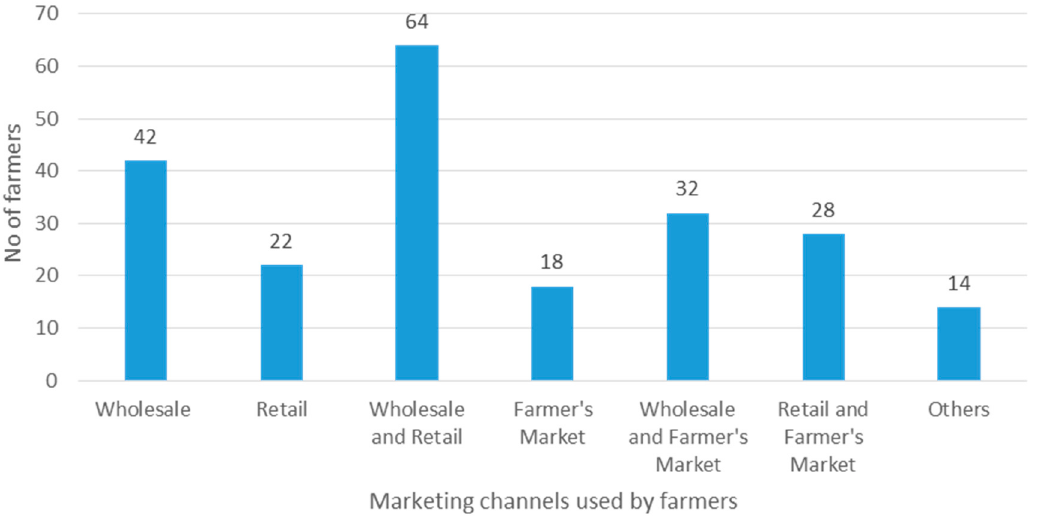
Figure 1. Farm produce marketing channels.